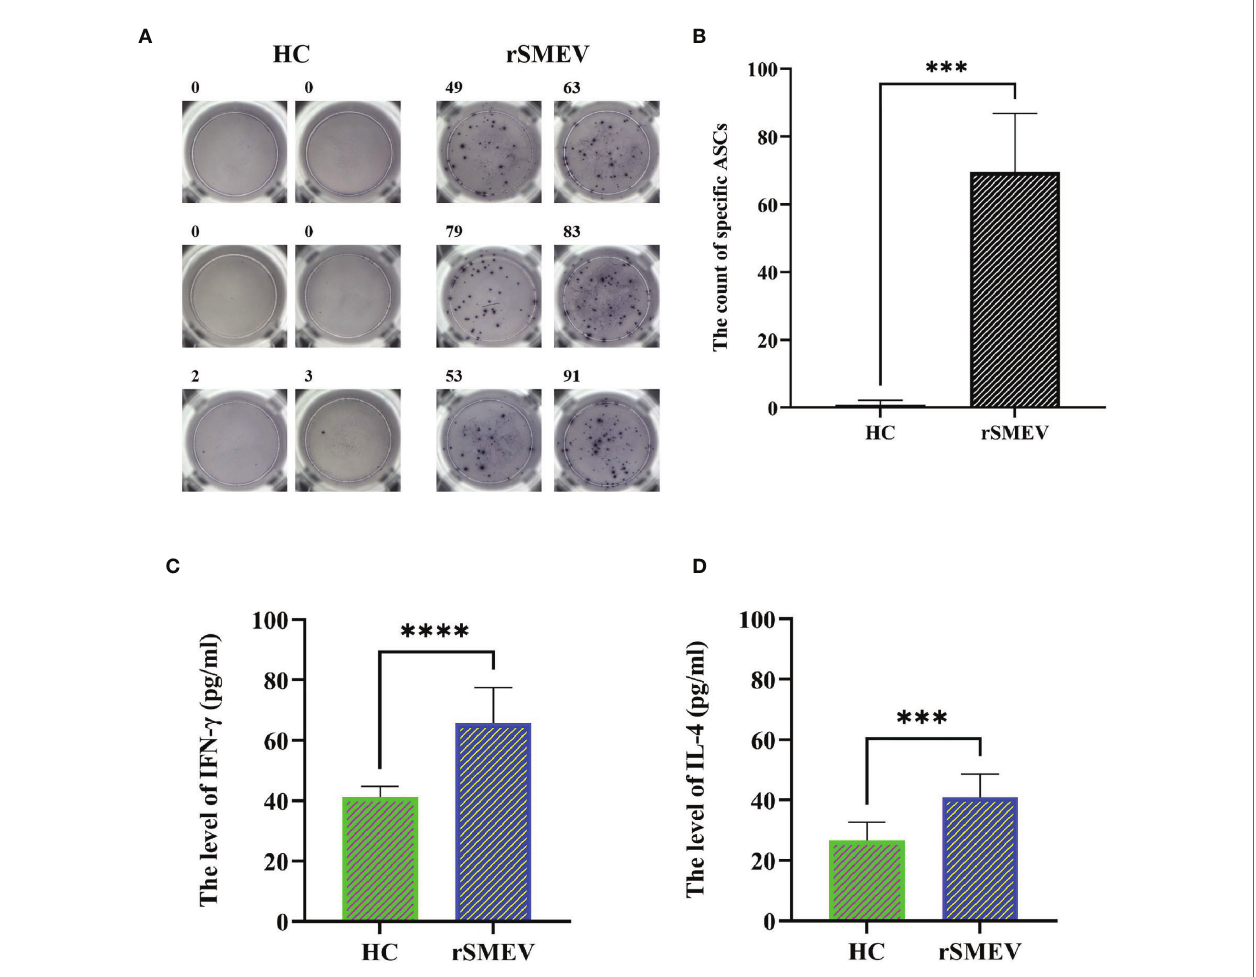
FIGURE 14 | The results of ELISPOT and ELISA experiments. (A) The representative ELISPOT spot diagram in HC and rSMEV groups. (B) The count of ASCs in the HC and rSMEV groups were signi fi cantly different (*** P <0.001) after using the two independent sample t -test, and the statistical test was two-tailed. The t-value was 9.671 and the degree of freedom was 5.059 (***P < 0.001). (C) The two independent sample t -test of the level of IFN- g between HC group and rSMEV group, and the difference was statistically signi fi cant (**** P <0.0001), the t-value was 6.247 and the degree of freedom was 18. (D) The two independent sample t -test of the level of IL-4 between HC group and rSMEV group, and the difference was statistically signi fi cant (*** P <0.001), the t-value was 4.652 and the degree of freedom was